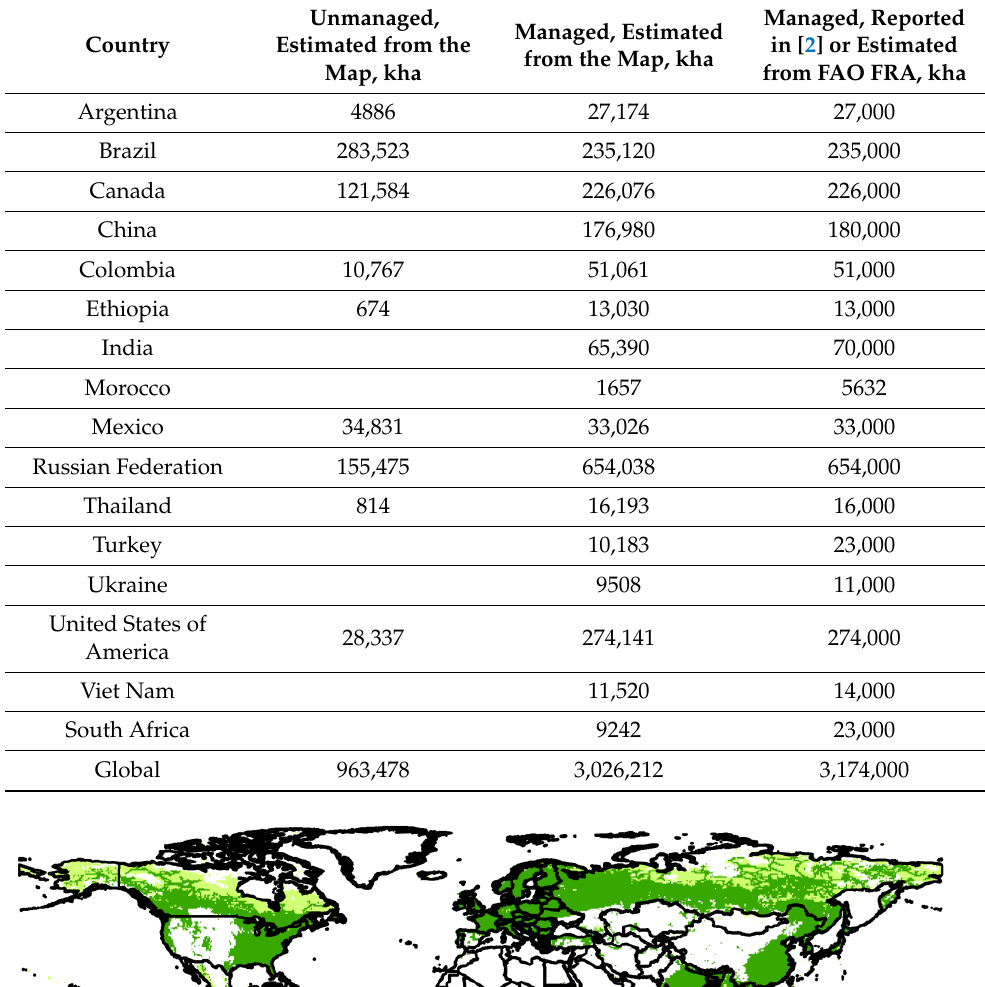
Table 1. Managed and unmanaged forest area estimated from the map, and managed forest area presented in Grassi et al., 2021 [2] or estimated from FAO FRA for selected countries and globally.